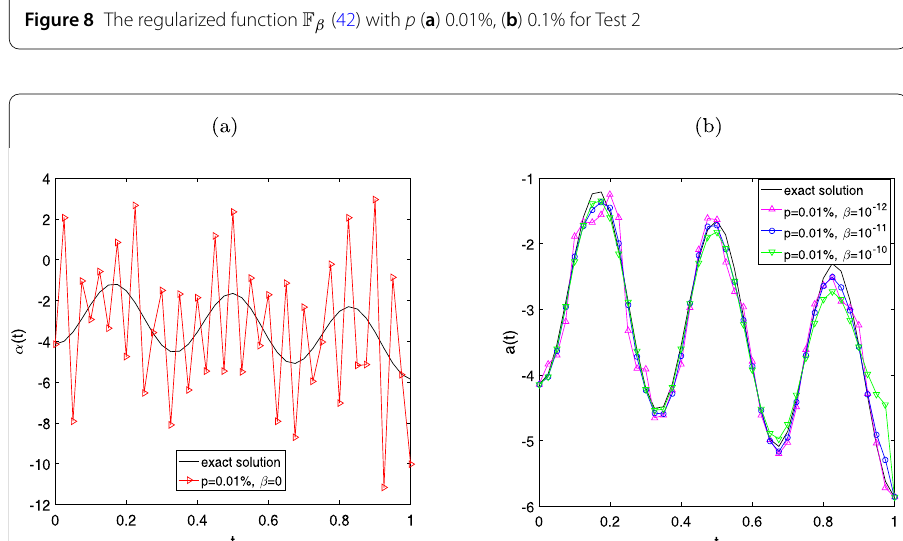
Figure 9 The analytical (43) and approximate α ( t ) with p = 0.01% for β : ( a ) 0 and ( b ) 10 –12 , 10 –11 , 10 –10 for Test